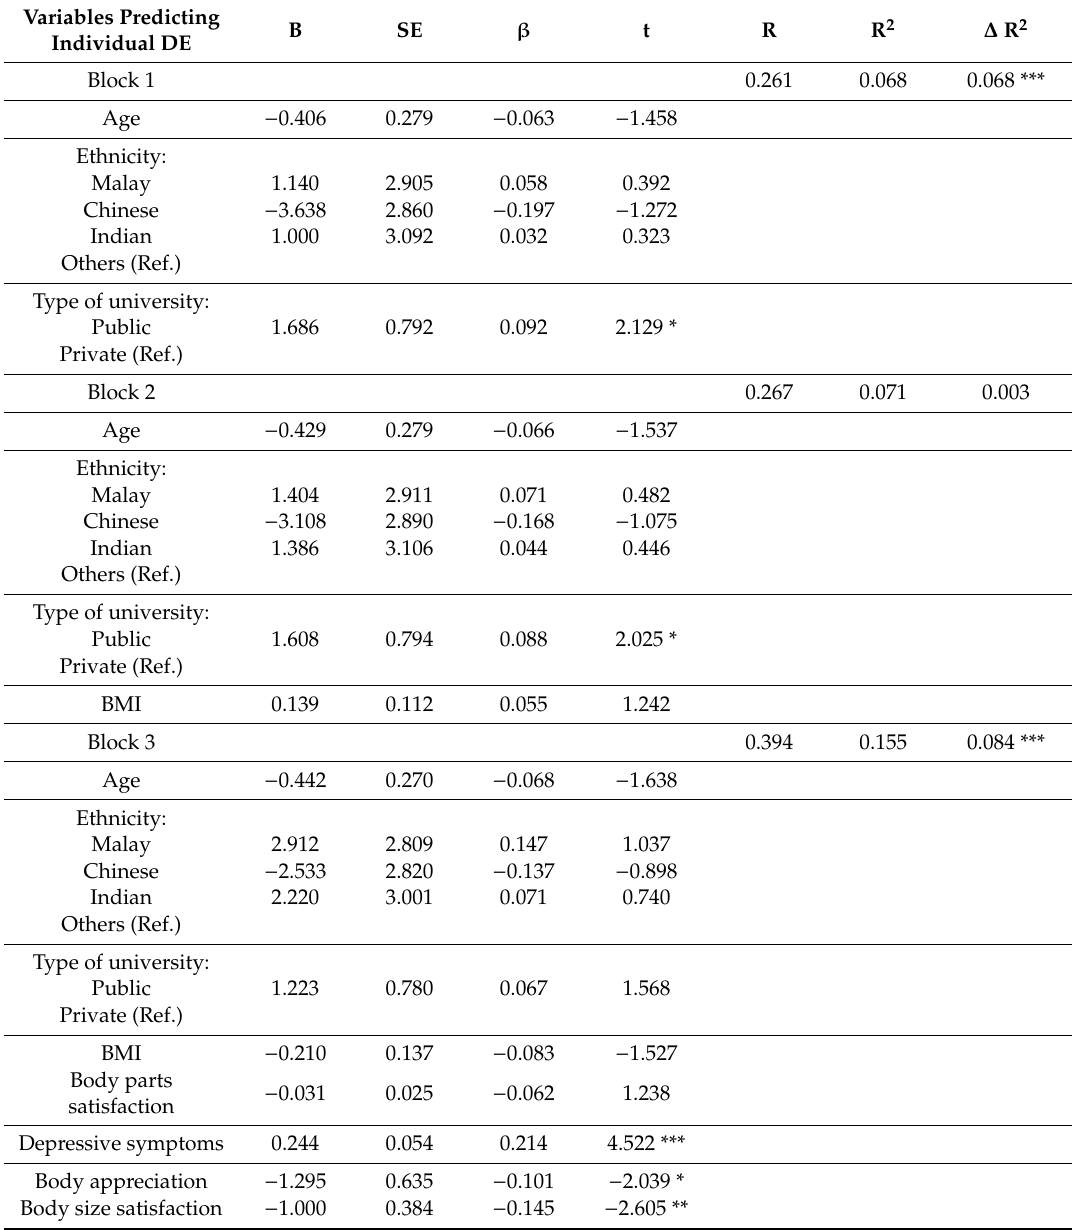
Table 5. Hierarchical multiple regression analyses for individual prediction of disordered eating (EAT-26) from body mass index, socio-demographic, and personal variables in females ( n = 520). Variables